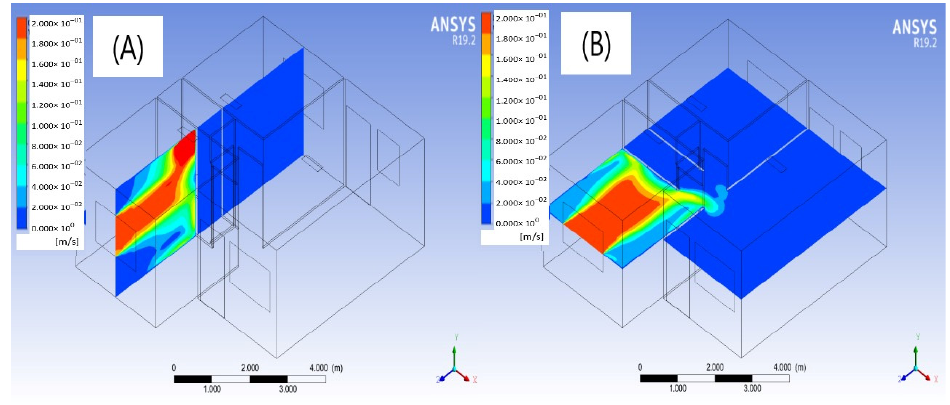
Figure 11. Velocity magnitude in the z–y plane ( A ) and in the z–x plane ( B ) for a rectangular channel, with the air outlet concentrated in room 1.